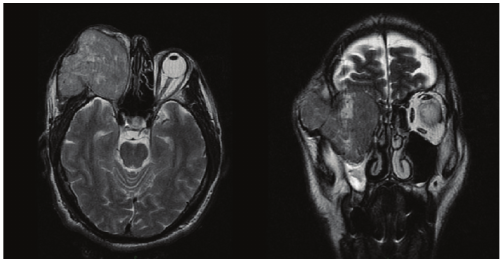
Figure 2: Axial and coronal MRI image showing a right intraconic and extrasonic mass with ocular globe displacement and temporal muscle and zygomatic bone infiltration.